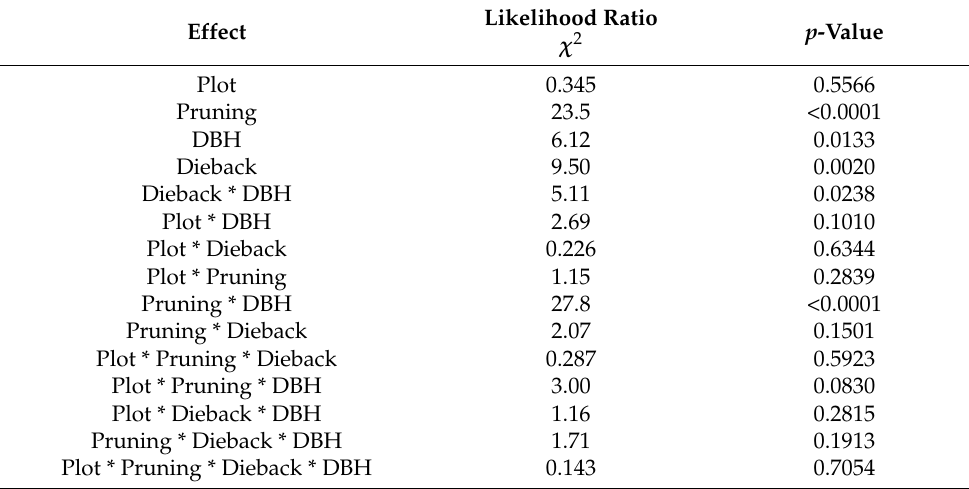
Table 3. Analysis of variance table for the ordinal logistic regression model (McFadden pseudo- r2 = 0.25) to predict assessed likelihood of failure from the effects of plot type (control, utility) pruning status (pruned, unpruned), trunk diameter 1.4 m above ground (DBH), percent crown dieback z , and their interactions. Odds ratios in Table 4 were computed for the significant effects of pruning, DBH, crown dieback, and their interactions.